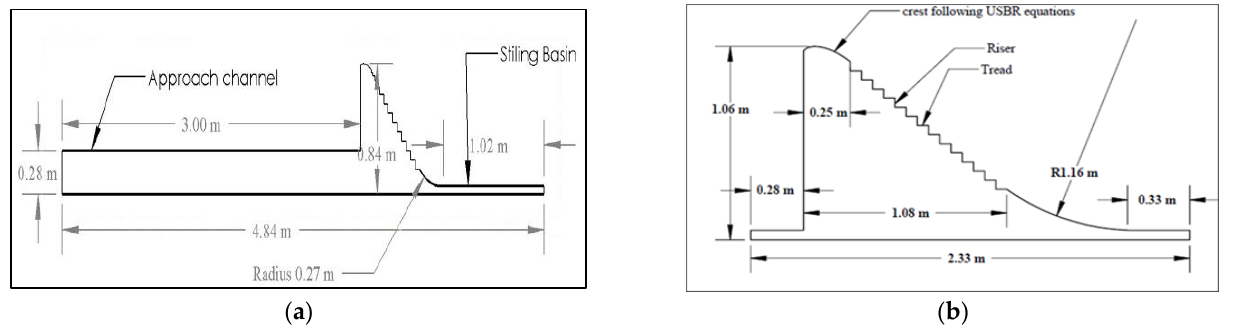
Figure 2. ( a ). Pictorial View of Model 1; ( b ) Pictorial View of Model 2. Table 4. Geometrical and physical properties of both models.